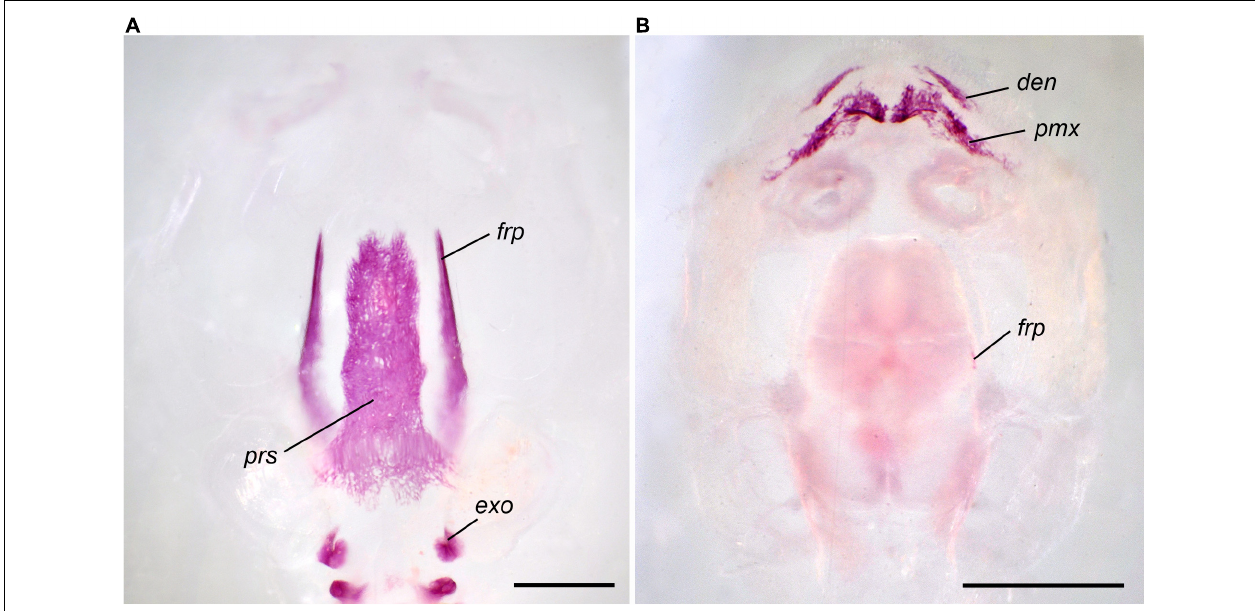
FIGURE 2 | First cranial bones to appear in Bombina variegata: (A) in norm II, Stage 37, 24 dph; (B) in T 3 2 × 10 − 8 M (early), Stage 35, 17 dph. Abbreviations: den, dentary; exo, exoccipital; frp, frontoparietal; pmx, premaxilla; prs, parasphenoid. Scale bar 1